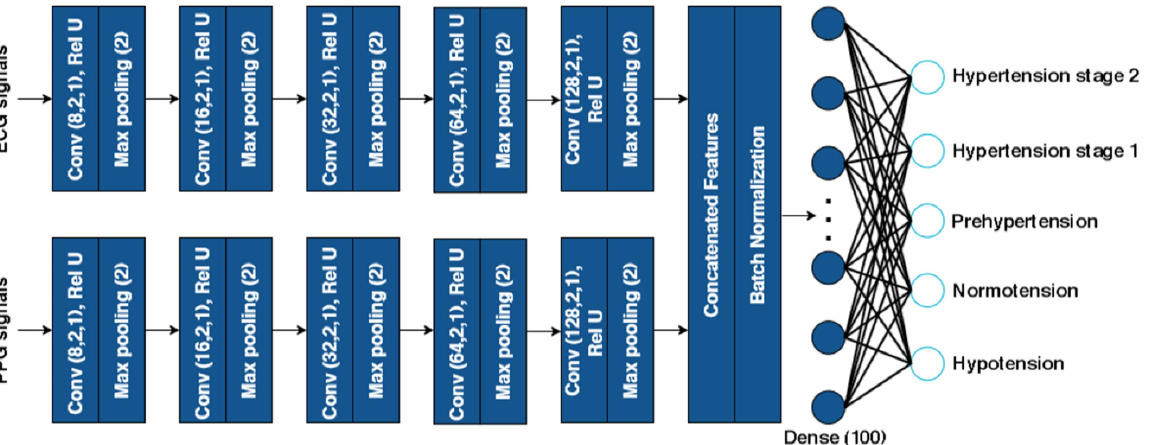
Figure 2. The proposed concatenated 1D CNN